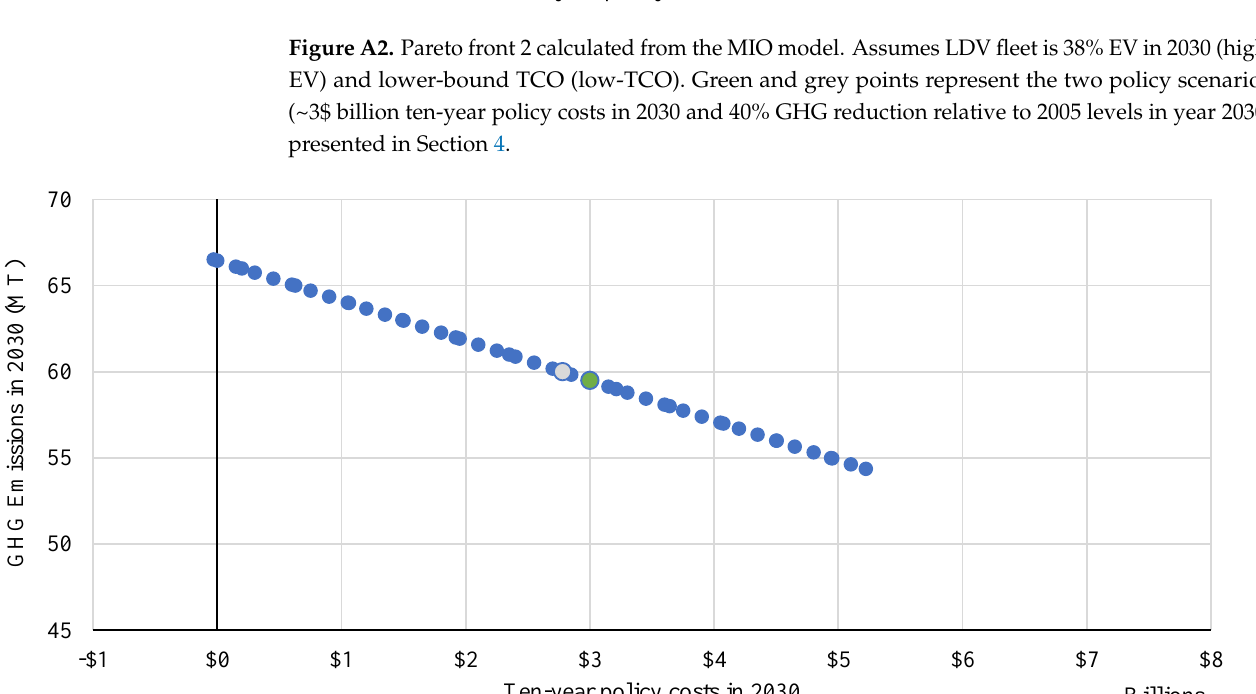
Figure A4. Pareto front 4 calculated from the MIO model. Assumes LDV fleet is 25% EV in 2030 (low-EV) and lower-bound TCO (low-TCO). Green and grey points represent the two policy scenar- ios (~3$ billion ten-year policy costs in 2030 and 40% GHG reduction relative to 2005 levels in year 2030) presented in Section 4. References 1.